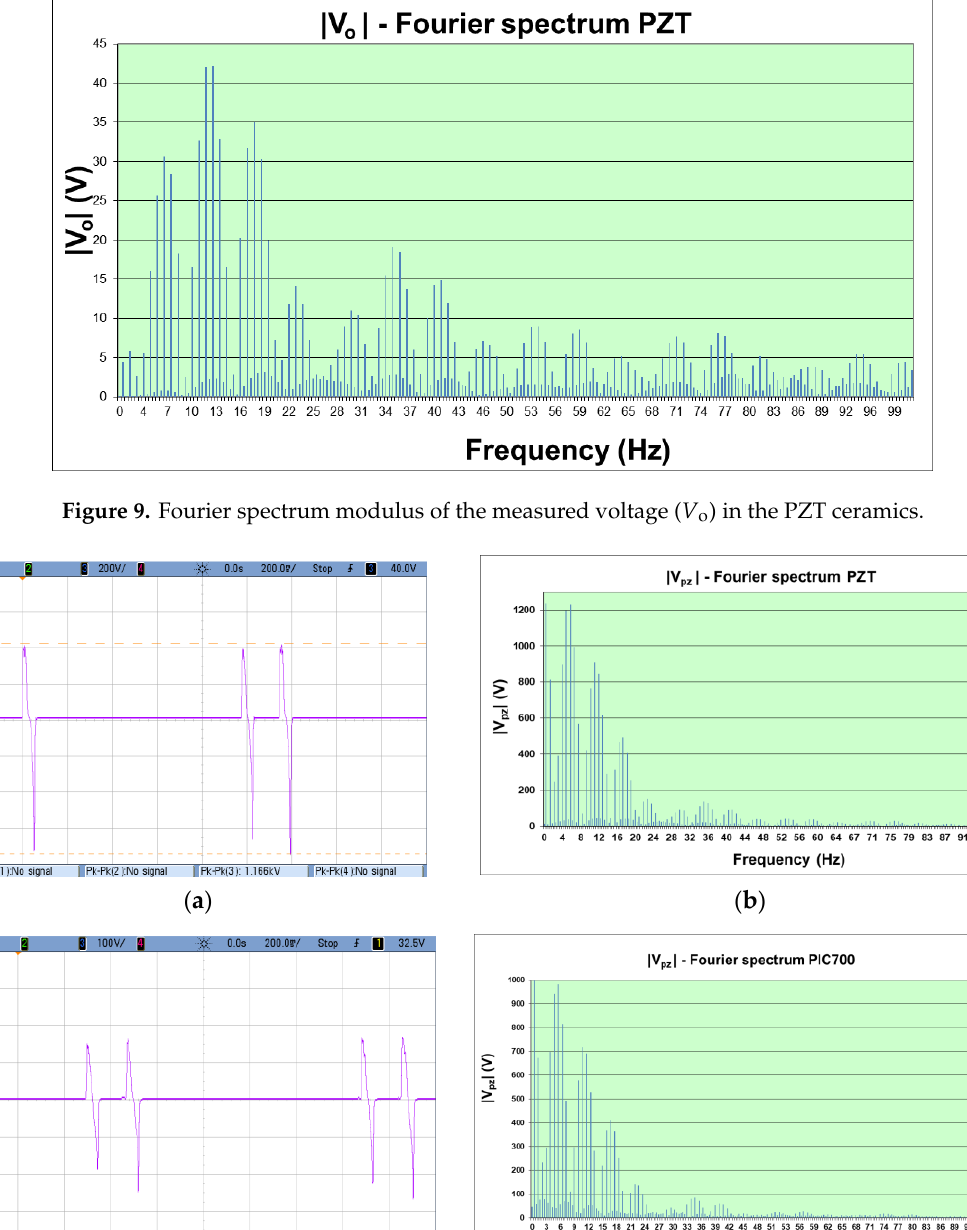
Figure 10. ( a ) PZT material measured voltage; ( b ) Fourier spectrum (modulus) of the active piezoelectrical generator for the PZT ceramic material; ( c ) lead-free ceramics measured voltage; ( d ) Fourier spectrum (modulus) of the active piezoelectrical generator for the PIC700 ceramic material.